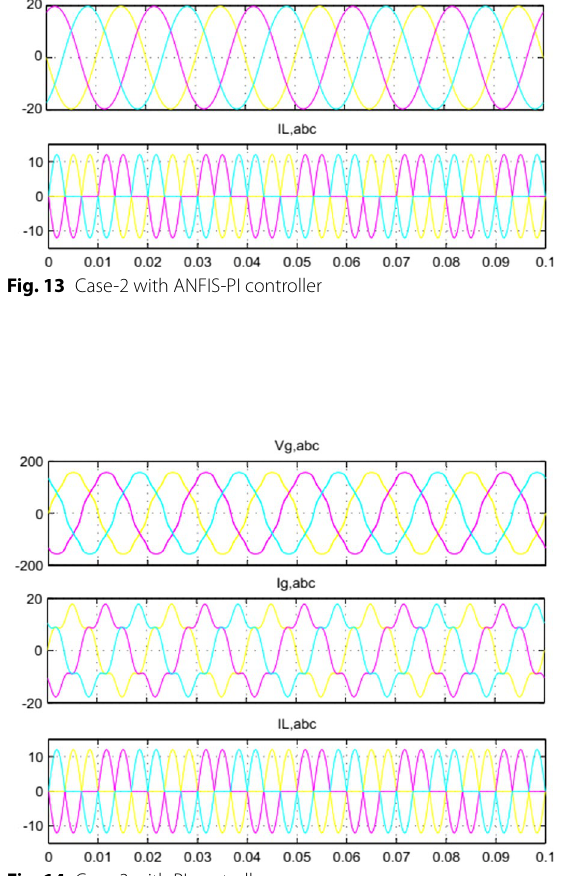
Fig. 14 Case-3 with PI